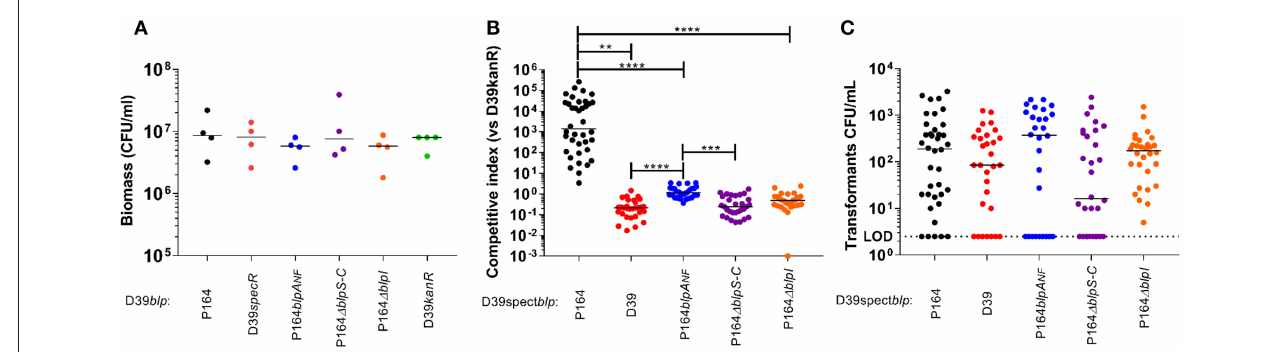
FIGURE 4 | Pneumocin BlpIJ production in a BlpA + intact strain promotes competition in dual-colonized biofilm. (A) Biomass of biofilm when strains were inoculated alone. (B) Competitive index when competitors were co-inoculated with a sensitive strain (D39kanR). (C) Dual Kan/Spect resistant transformants per well. LOD was 2.5 CFU/mL. There were no statistical differences between groups in A and C. Median values of 3 independent experiments are shown for each graph. Kruskal-Wallis test for multiple comparisons was used to determine statistical significance. P -values: **0.0015, ***0.0004, **** <